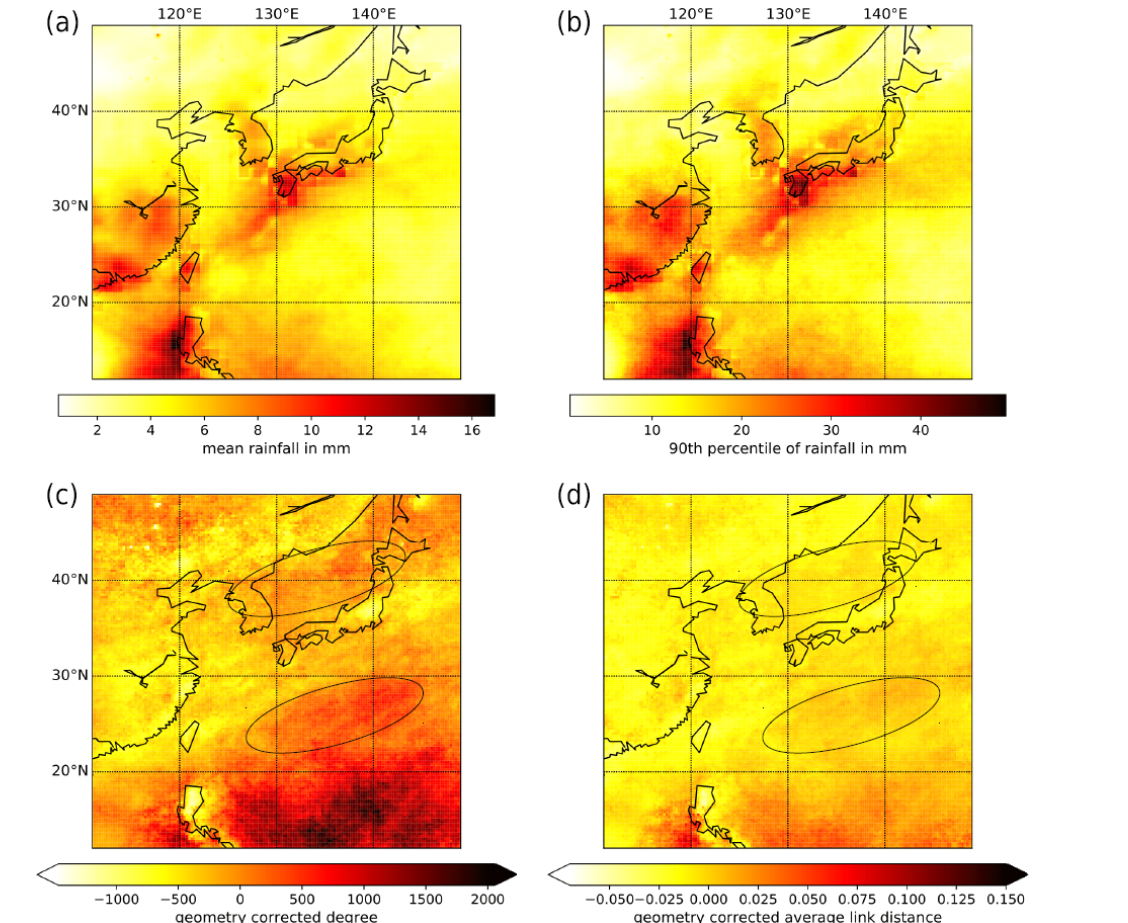
Figure 2. (a) Mean and (b) 90th percentile of daily rainfall sums between 25 April and 3 August over the study region. (c) Geometry- corrected degree and (d) average link distance of the climate network constructed based on synchronous occurrences of heavy rainfall events between 25 April and 3 August. The identified bands of elevated degree and average link distance are indicated by ellipses for better visual identification in panels (c) and (d)